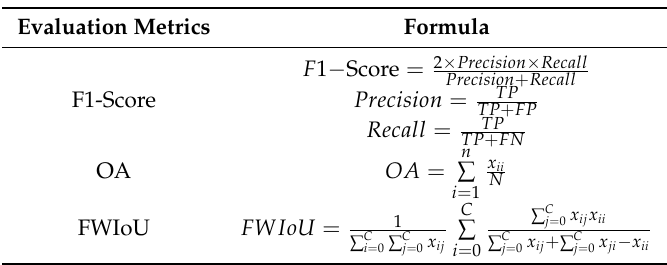
Table 1. Evaluation